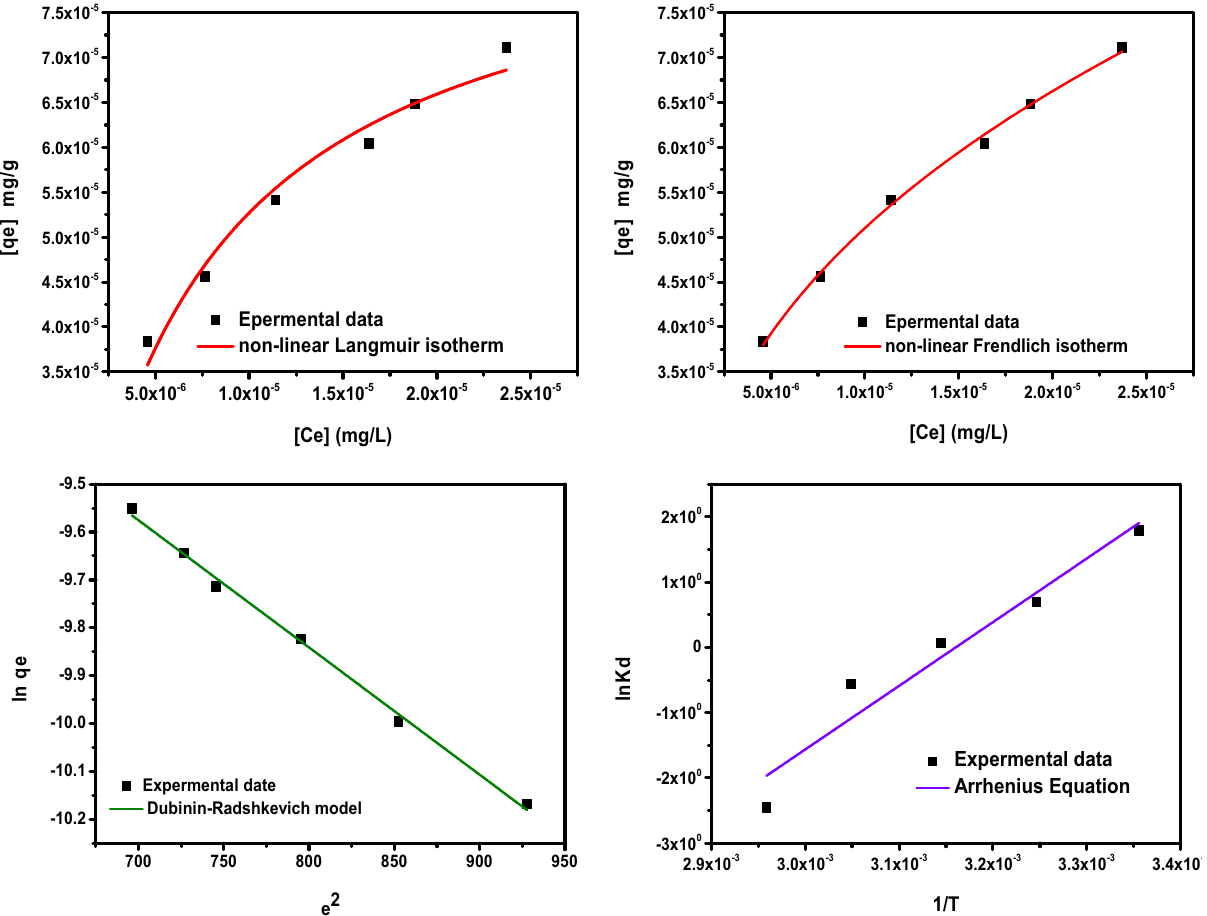
Figure 9. isotherm models of dye adsorption. ( a ) Langmuir ( b ) Freundlich ( c ) Dubinin-Radushkevich (D-R) ( d ) temperature